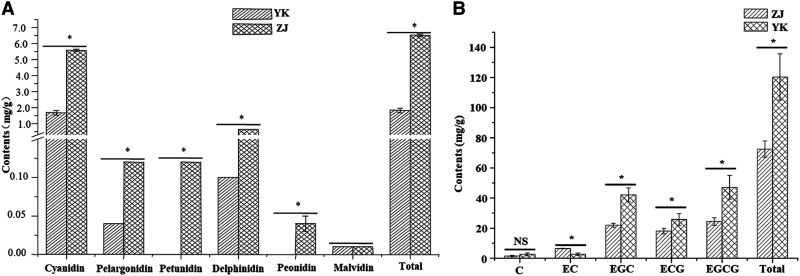
Comparison of contents of anthocyanins and catechins of ZJ and YK. (A) Comparison of contents of anthocyanins of ZJ and YK (B) Comparison of contents of catechins of ZJ and YK; ANOVA results showed the significant (P < 0.05) difference and marked ‘*’.